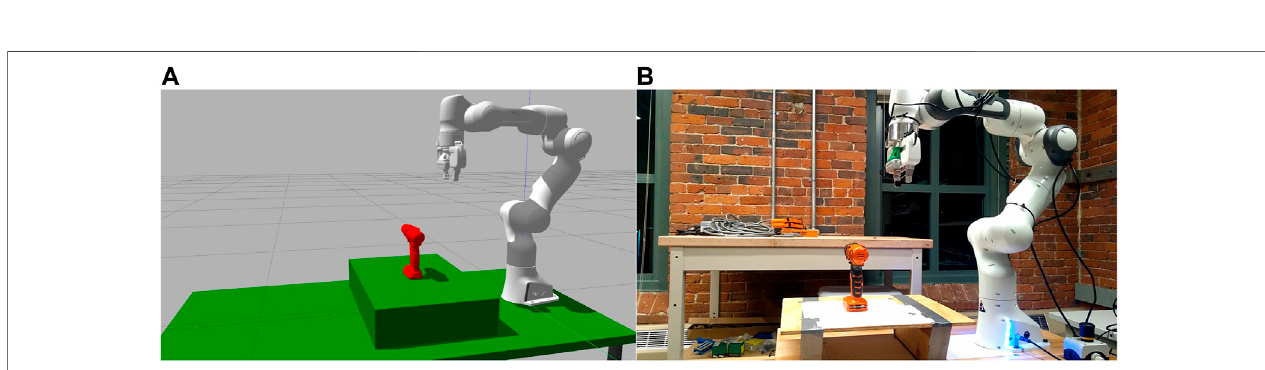
Frontiers in Robotics and AI |